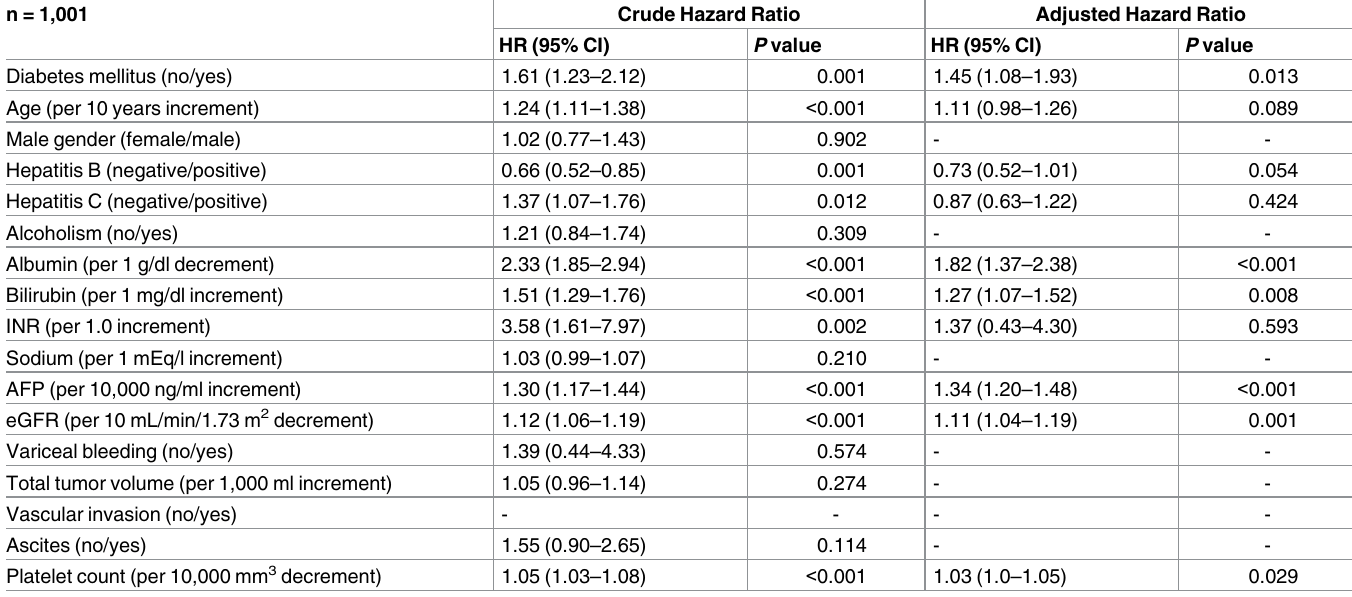
Table 3. Univariate and multivariate Cox survival analysis in patients with BCLC stage 0 and stage A hepatocellular carcinoma. n =